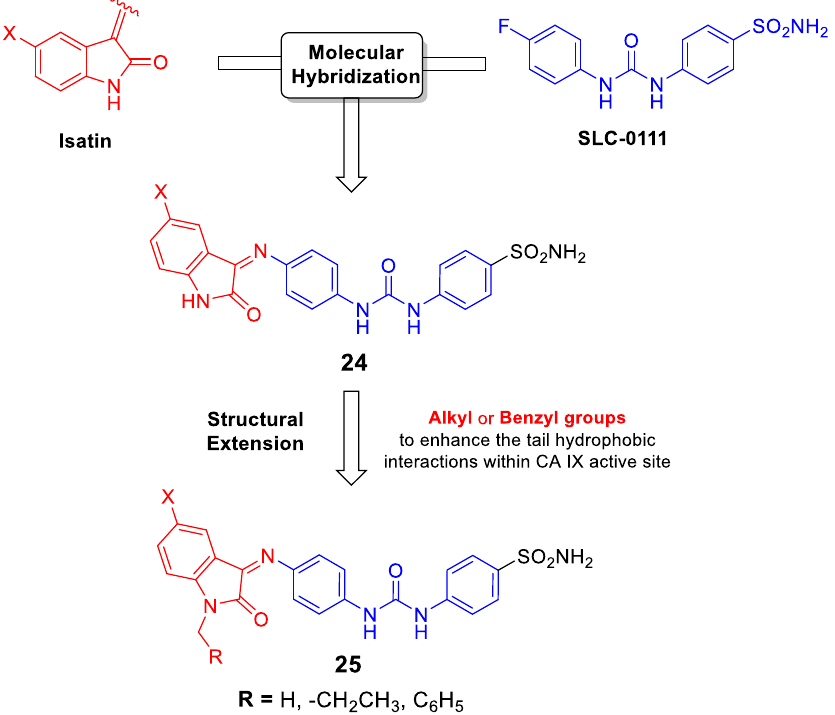
Figure 5. Design of the N -(un)substituted isatins-SLC-0111 hybrids 24 and 25 [157,158].